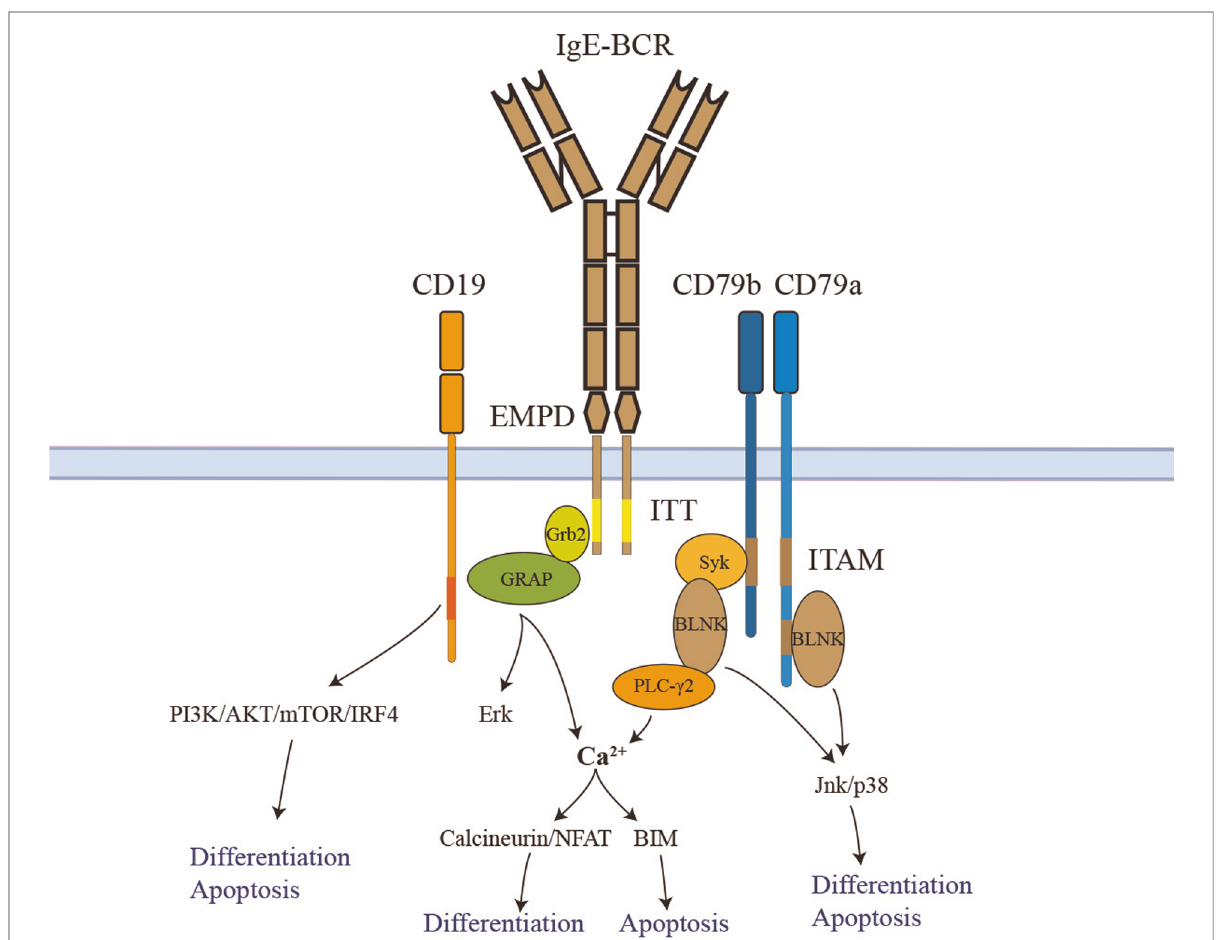
FIGURE 2 The signaling pathways of IgE-BCR. IgE-BCR is non-covalently associated with CD79a and CD79b, both of which have an ITAM motif in their cytoplasmic tail. Phosphorylated ITAM recruits and activates Syk, which phosphorylates BLNK after activation. In addition, CD79a could recruit and activate BLNK by a non-ITAM tyrosine residue. BLNK controls calcium signaling pathways via activating PLC- γ 2. The downstream signaling calcineurin/NFAT promotes IgE + PC differentiation. Sustained elevation of calcium contributes to BIM-dependent apoptosis. BLNK also facilitates IgE + PC differentiation and apoptosis via Jnk/p38. In addition, the ITT motif recruits Grb2 and Grb2-related adaptor proteins to enhance BCR downstream signaling. The long isoform of IgE-BCR has an additional EMPD region that could interact and activate CD19. Activated CD19 triggers IgE + PC differentiation and apoptosis via the PI3K-Akt-mTOR-IRF4 pathway. ITAM, immunoreceptor tyrosine-based activation motif; EMPD, extra-membrane proximal domain; ITT, immunoglobulin tail tyrosine; GRAP, Grb2-related adaptor